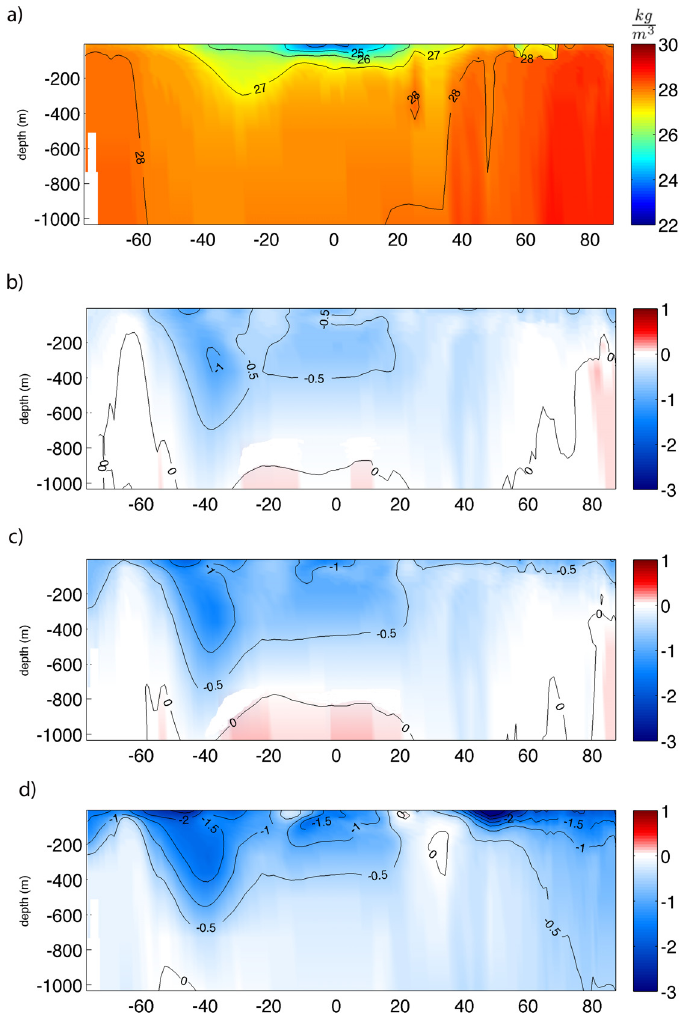
Figure 10. Zonally averaged vertical profile (0-1000 m) of annual mean density (kg/m 3 ) for (a) CTRL experiment and differences between (b) 4CO , (c) 8CO and (d) 16CO and the CTRL 2 2 2